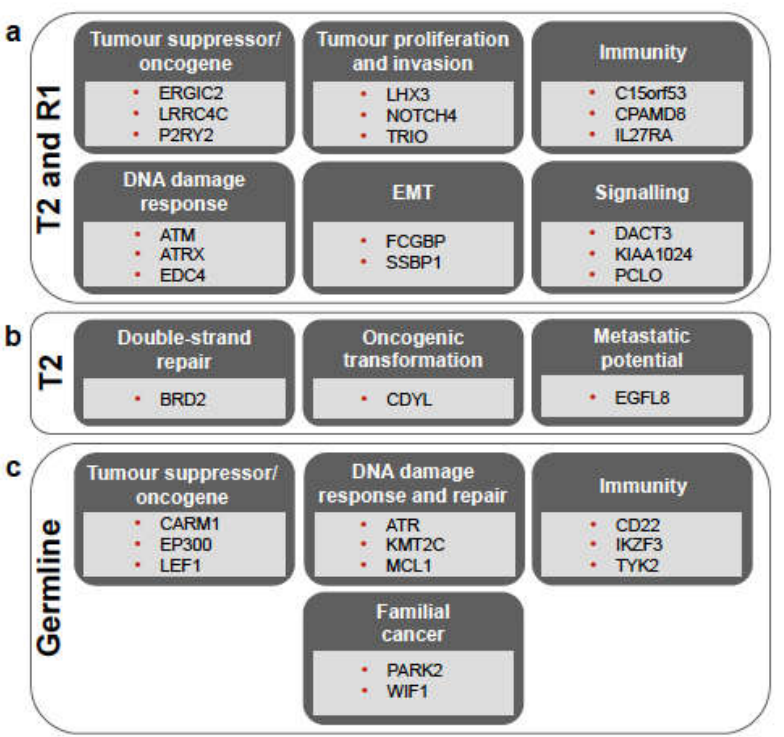
Figure 2. Overview of the main biological processes in which mutated genes are involved, shown for the somatic mutations shared between T2 and R1 ( a ), those unique to T2 ( b ), and for the germline variants ( c ). For more details, see Supplementary Tables S1b, S1c, and S4b, respectively. EMT = epithelial-mesenchymal transition.